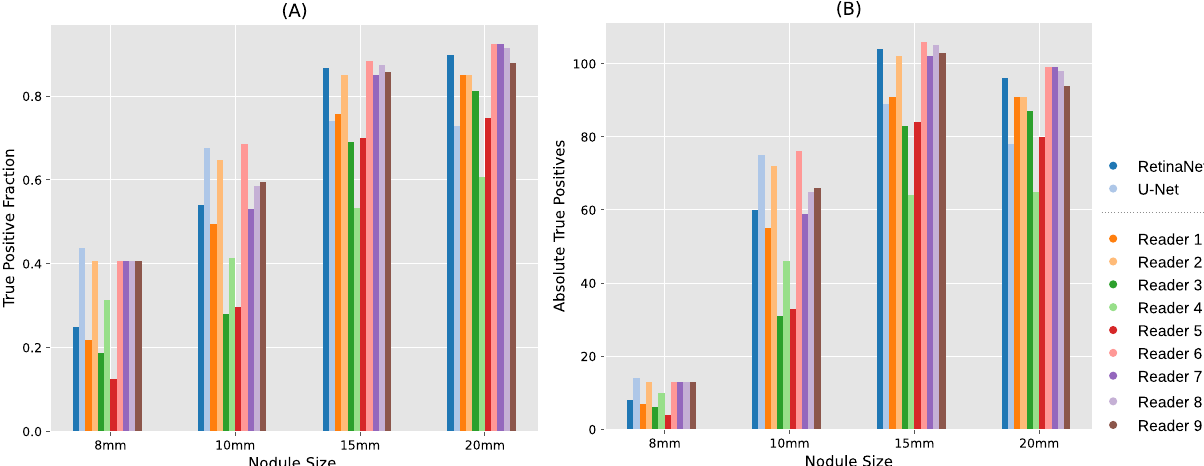
Figure 4. Comparision of detection performance by nodule size ( A ) Relative true positive fraction ( B ) absolute number of true positives for RetinaNet CNN, U-Net CNN and readers R1–R9. The plot was generated using Matplotlib 27 .